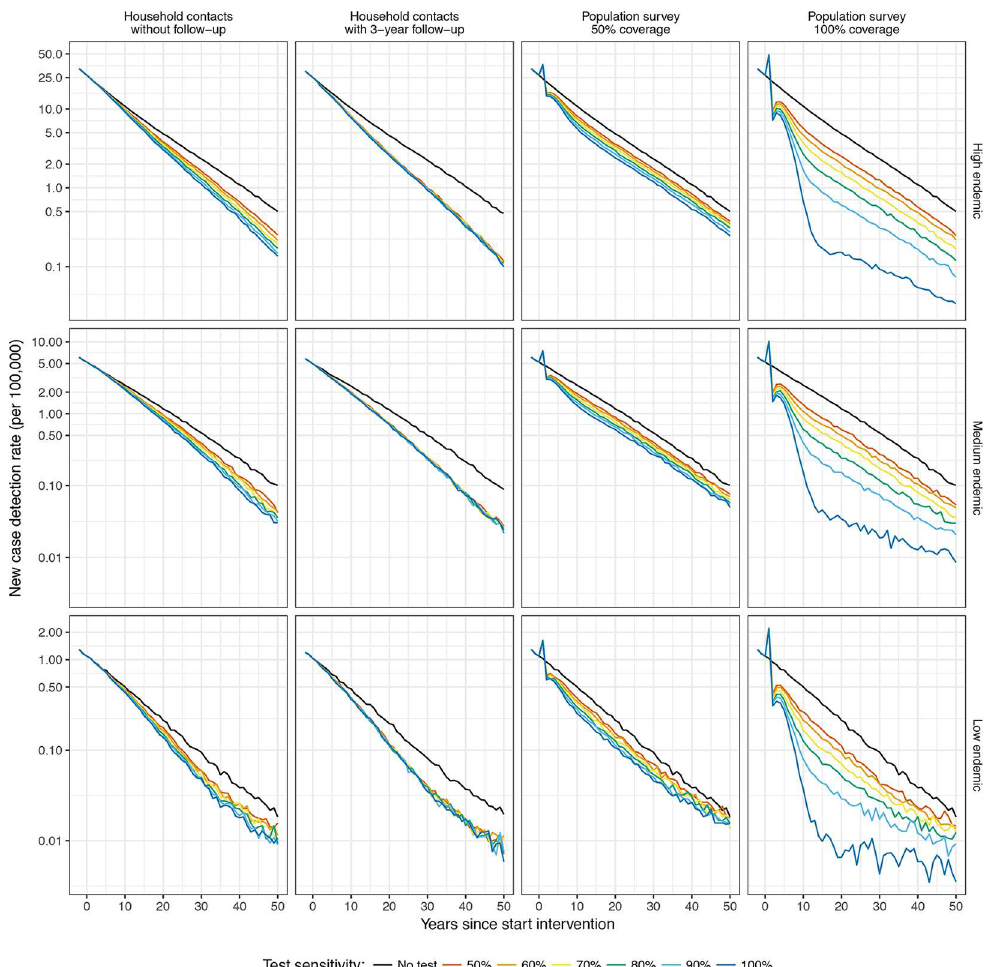
Fig 1. Impact of a diagnostic test used in household contacts and a population survey on the NCDR under various assumptions of sensitivity in a high, medium and low endemic setting. Four strategies were assessed: testing in 1) household contacts without follow-up, 2) household contacts with a 3-year follow-up, 3) a population survey with a coverage of 50%, and 4) a population survey with a coverage of 100%. Test sensitivities vary between 50% and 100%. The black line represents a strategy in which no diagnostic test was used (i.e. continuation of current control). High endemic is defined as 25 per 100,000 population, medium as 5 per 100,000, and low as 1 per